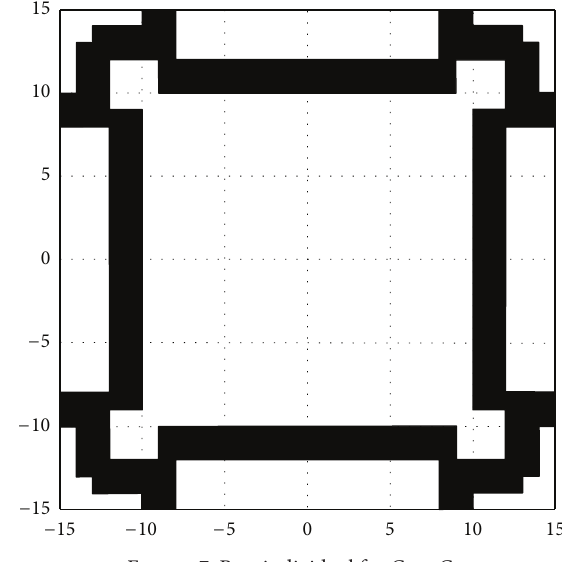
Figure 7: Best individual for Case C.